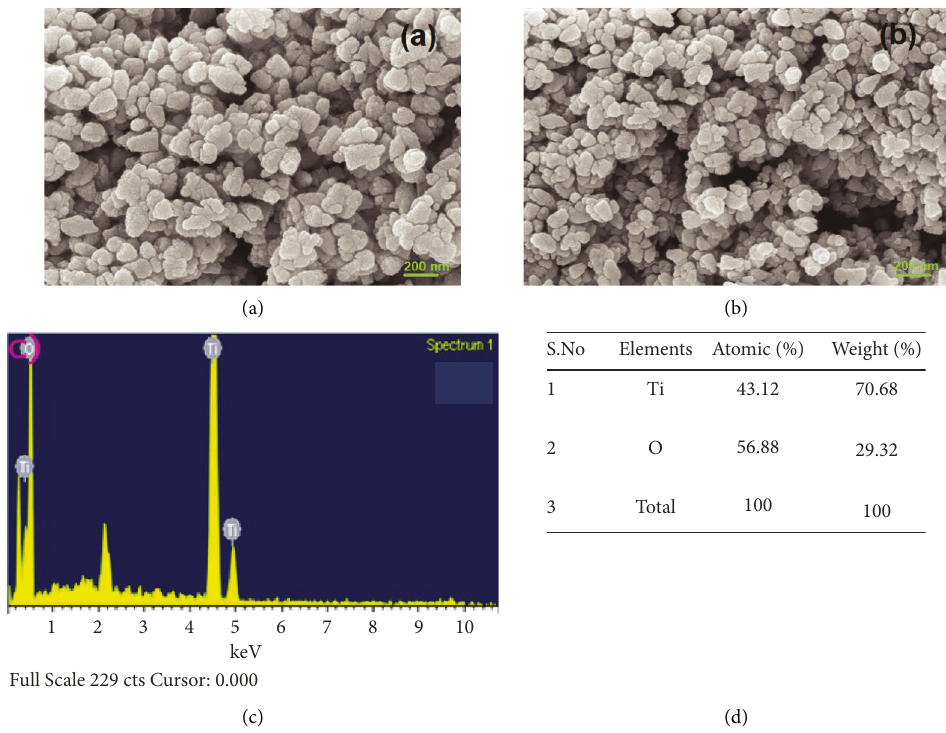
Figure 4: (a and b) SEM images, (c) EDX spectrum, and (d) the table of synthesized Bi-TiO